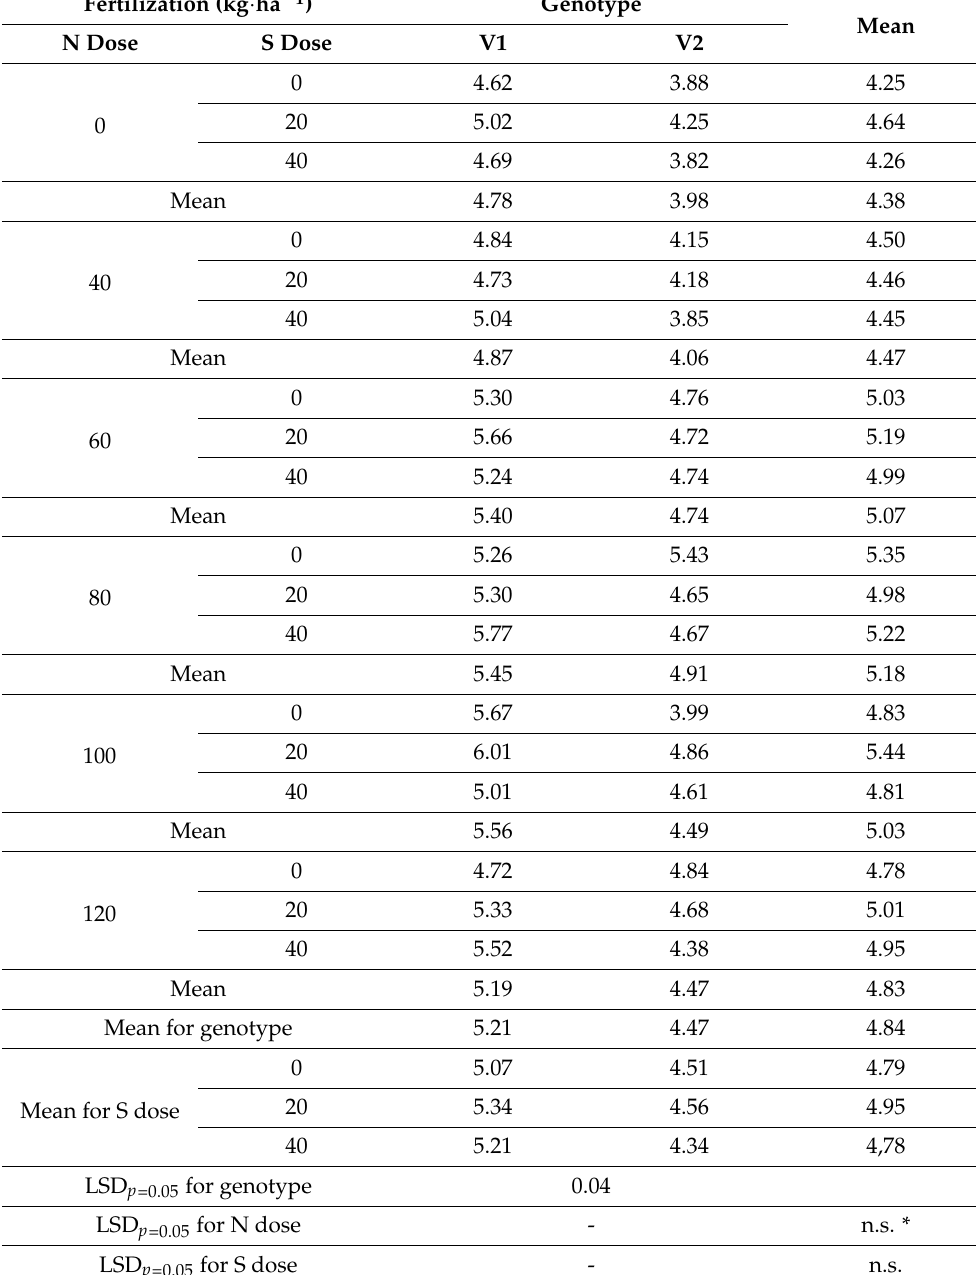
Table 3. Grain yield (Mg ha − 1 ) of winter wheat genotypes under